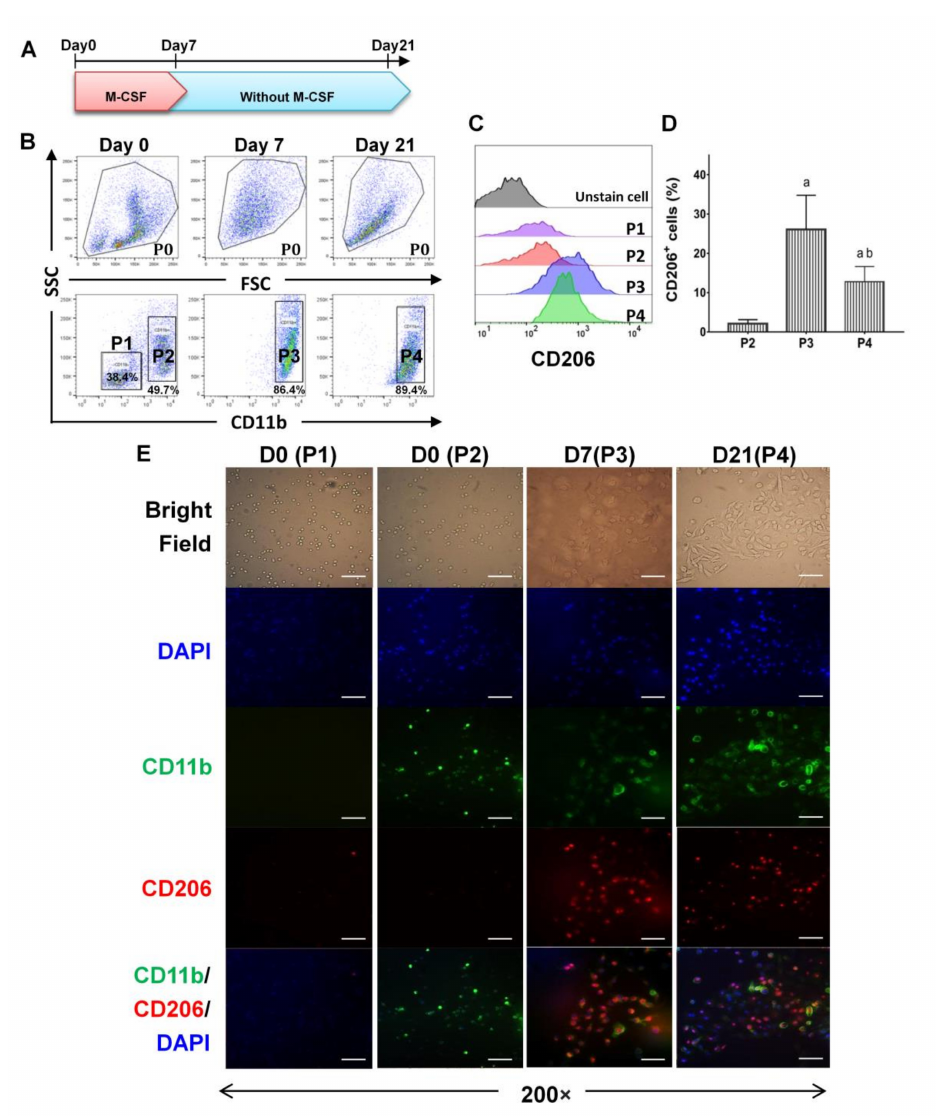
Figure 1. The expression of CD206 was maintained predominantly on CD11b + macrophages after withholding of macrophage colony-stimulating factor (M-CSF) supplement. ( A ) The mononuclear cells collected from murine bone marrow were differentiated into macrophages in vitro in the pres- ence of 50 ng/mL of M-CSF for 7 days. In the end of day 7, media were replaced by a fresh media (RPMI 1640 with 10% of fetal bovine serum) without M-CSF supplement then the cells were cultured continuously for additional 14 days. ( B ) Flow cytometry profiles of CD11b + monocytes/macrophages on day 0, day 7 and day 21, representatively. ( C , D ) The expression of CD206 in CD11b + cells were determined by flow cytometry. Data were analyzed using FlowJo V10 software and statistical calculation was presented as mean ± SD, n = 6. a, p < 0.05 when compared with P2; b, p < 0.05 when compared with P3. ( E ) Representative data of immunocytochemistry of bone marrow de- rived macrophages treated with M-CSF through day 0 to 7, and after supplemental interruption till day 21. Cells were stained with CD11b (green) and CD206 (red) and the nuclei were stained with 4 (cid:48) ,6-diamidino-2-phenylindole (DAPI) (blue). Scale bar is 50 um (magnification 200 × ). 2.2. Sustainable Expression of CD206 on Single Cell after Withholding of M-CSF